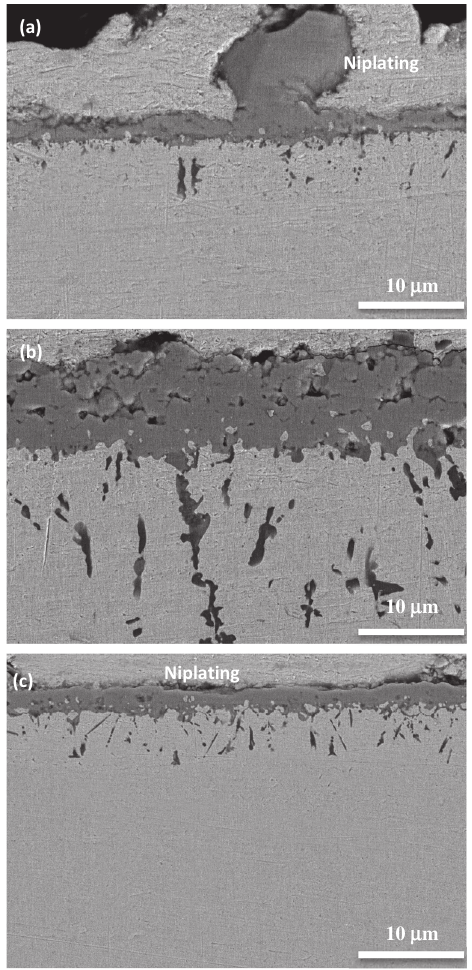
Figure 4: Cross-sectional morphologies of Inconel 740H after oxi- dation: (a) 750°C, in static air, (b) 850°C, in static air and (c) 750°C, in pure